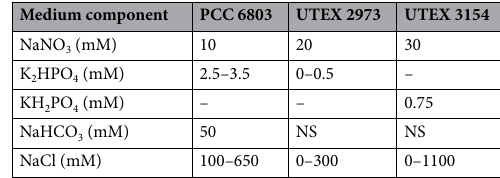
Table 2. Summary of the concentration ranges where the highest growth was observed in the 1D screening.